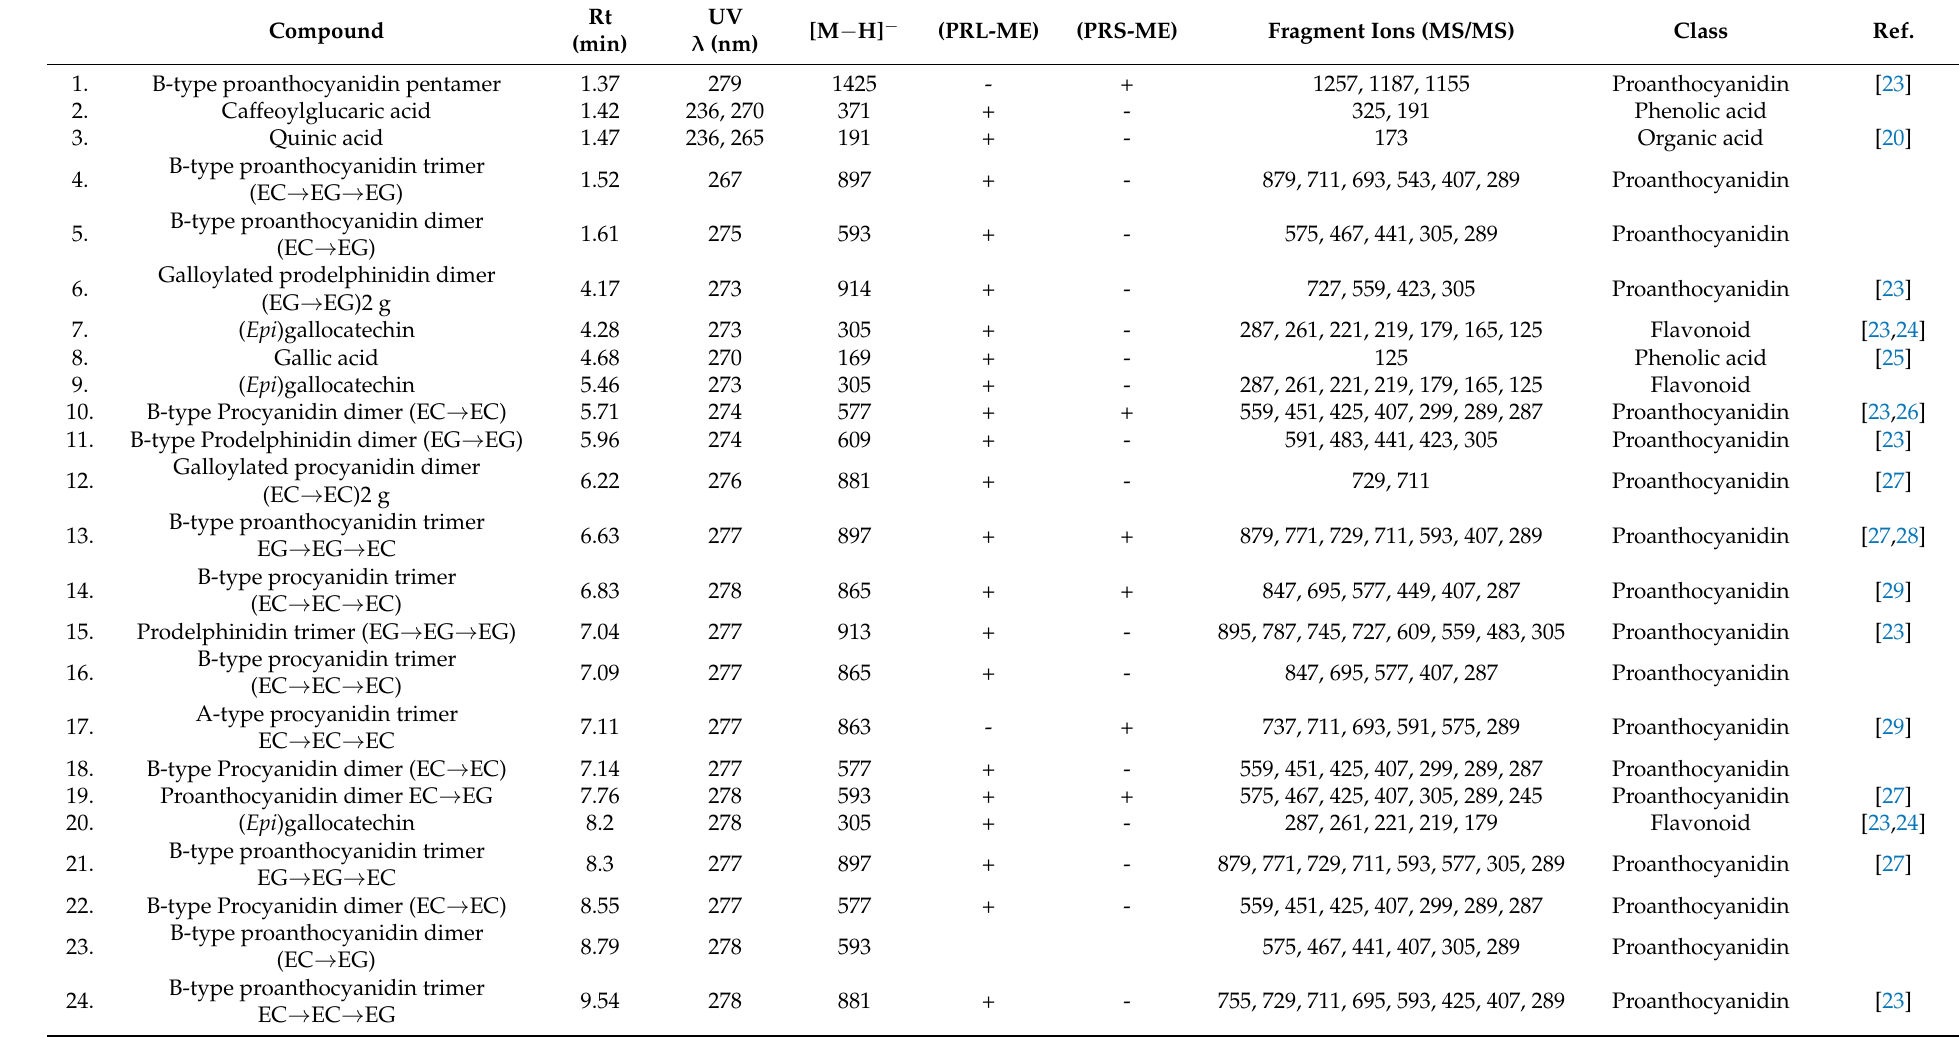
Table 2. Identified metabolites in P. racemosa leaf methanol extract (PRL-ME) and stem methanol extract (PRS-ME) using HPLC-PDA-ESI-MS/MS in negative ion